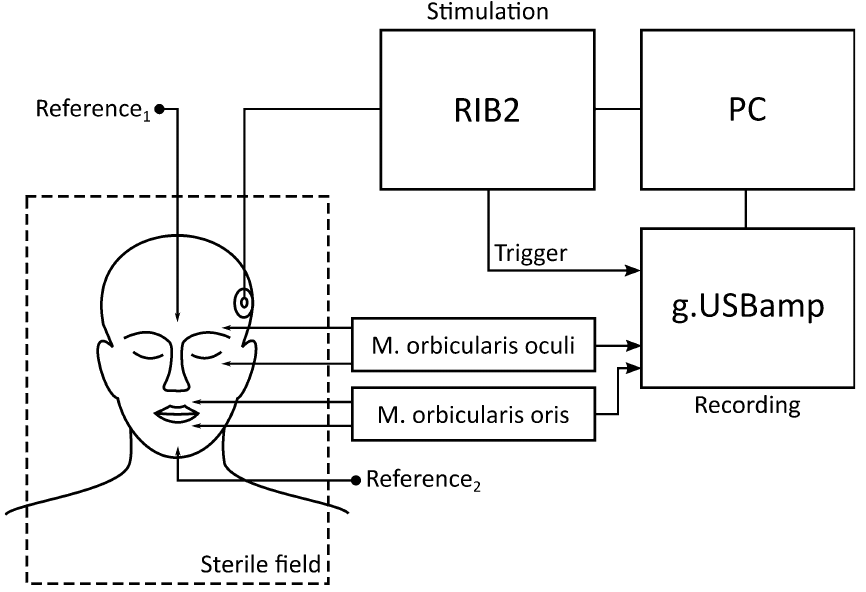
Figure 1. Experimental setup for intraoperative EMG recordings. The setup consisted of a PC for stimulation and measurements control, a research CI interface (RIB2) for stimulation and a g.USBamp biosignal amplifier to record two EMG channels.